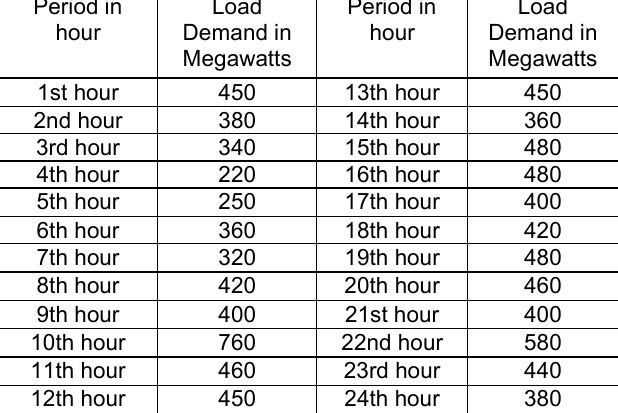
Table 3. Thermal generator power dispatch status\